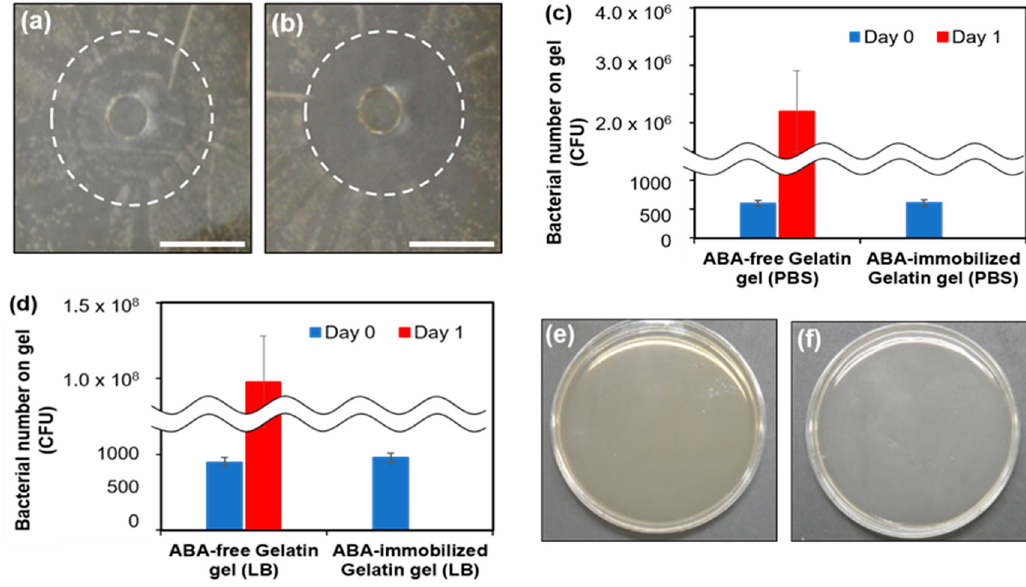
Figure 4. Photographs of the antibacterial evaluation on E. coli : ( a ) ABA-free gelatin gel and ( b ) ABA-immobilized gelatin gel. The bars represent 1 cm. Measurements of bacterial count on the gel surface: ( c ) PBS and ( d ) LB medium. Agar medium coated with PBS immersed in gel: ( e ) Gelatin without an antibacterial agent and ( f ) gelatin mixed with an antibacterial agent.